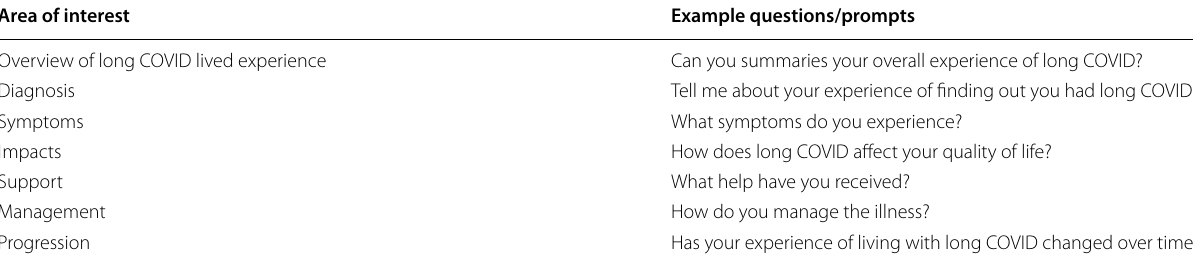
Table 2 Overview of the semi-structured interview schedule Area of interest Example